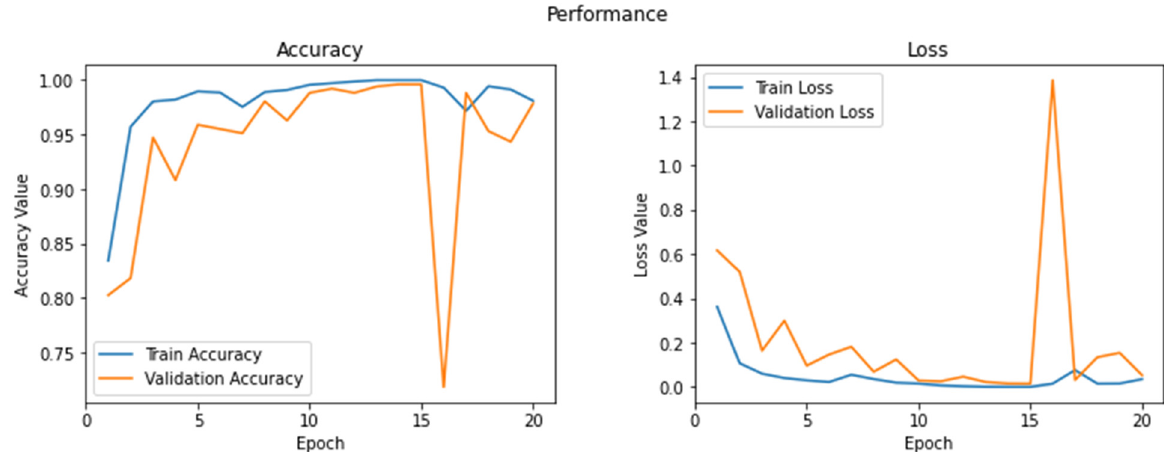
Figure 10. Accuracy plot and loss plot for qiskit.basicaer with ResNet34.